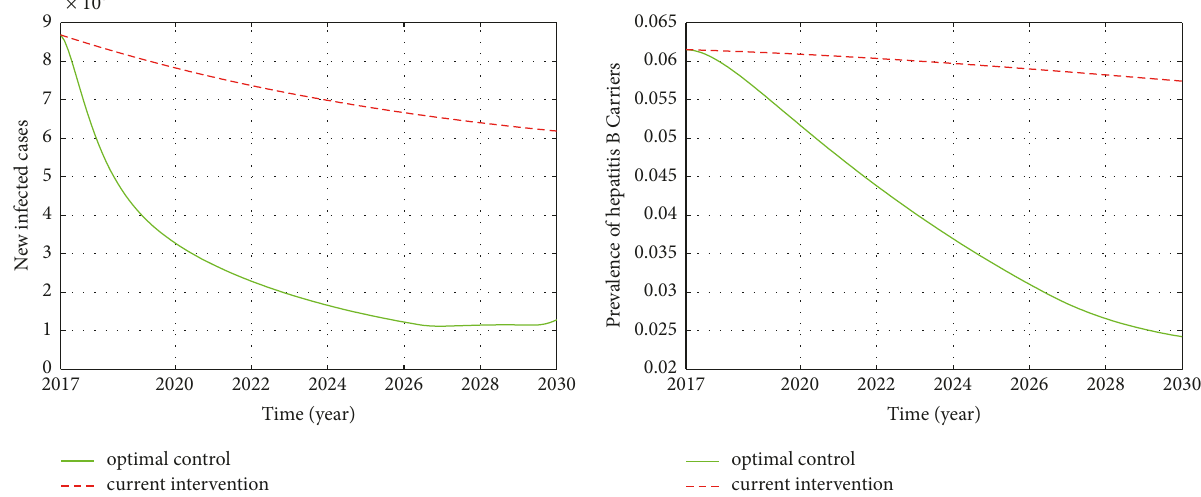
Figure 7: Simulations of new infected cases (left) and prevalence of chronic carriers (right) under optimal control and current interventions from 2017 to 2030.